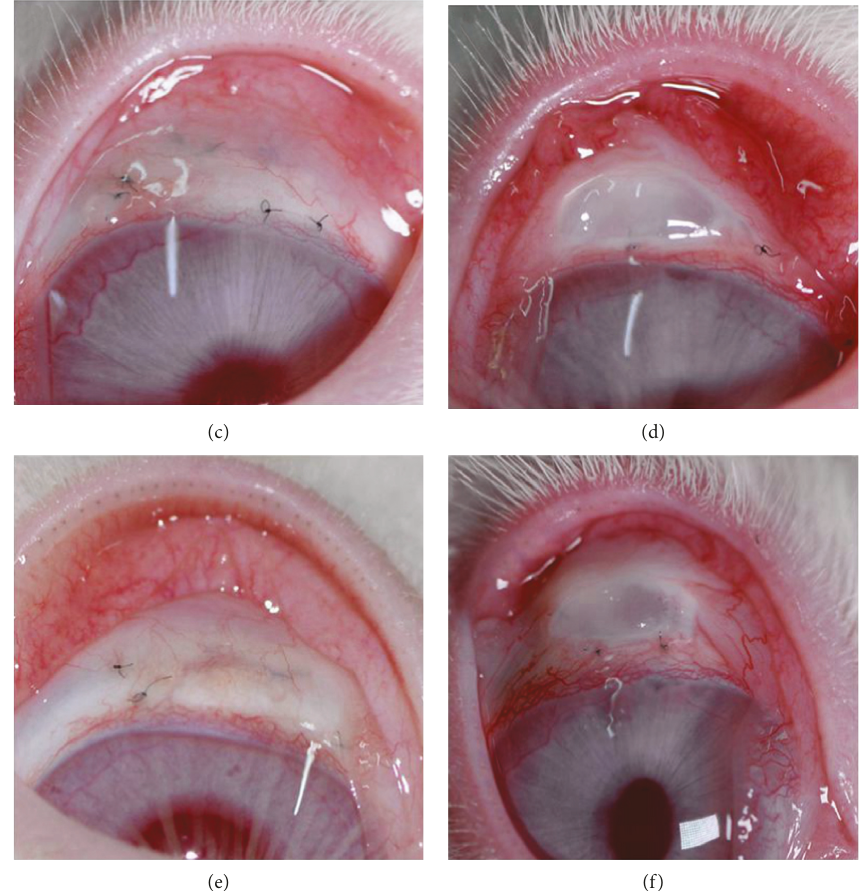
Figure 6: Bleb photograph examples in rabbit subconjunctival scar models 20 days after the surgery. Compared with the control group (a), 5-fluorouracil (5-Fu) treatment group (b) had a nearly normal distribution of blood vessels with filtering blebs low and flat. Compared with the control group (a), bevacizumab (BVZ) treatment (c) and 5-Fu+BVZ groups (e) showed slightly higher and diffused filtering blebs, and the distribution of blood vessels was not obvious. Compared with the control group (a), mitomycin C (MMC) (d) and MMC+BVZ groups (f) showed more conjunctival blood vessels with obviously bulged filtering blebs.